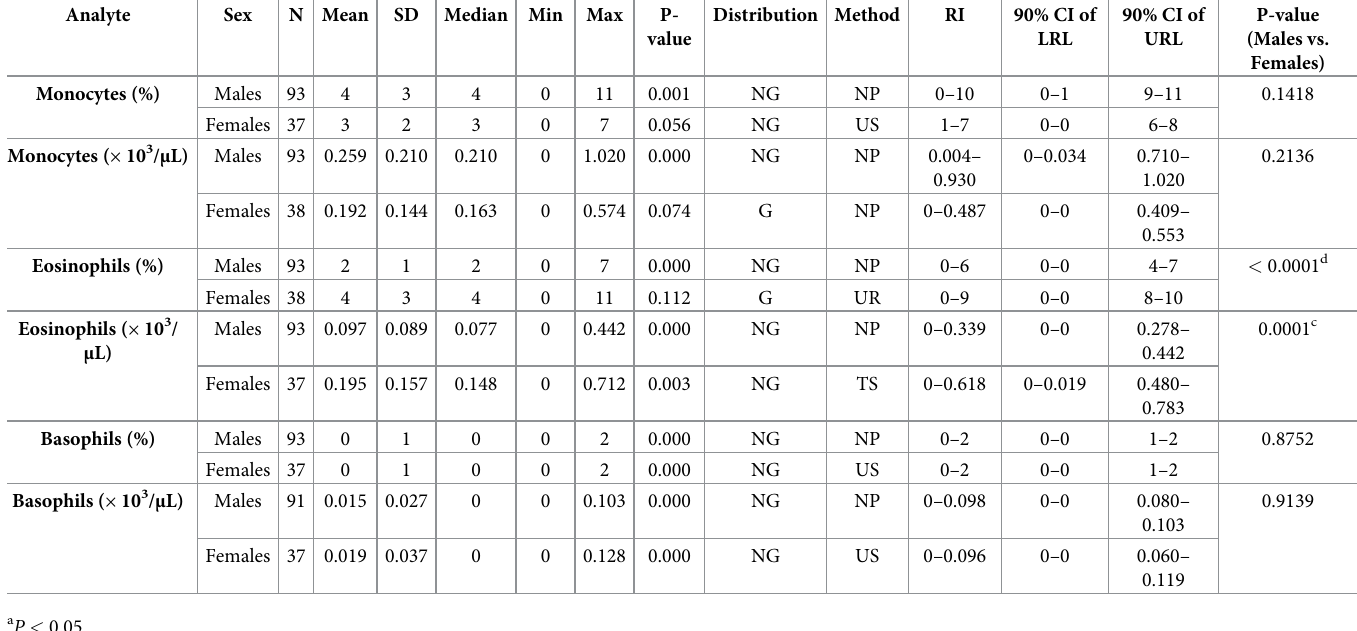
Adult reference intervals for serum biochemistry were partitioned by sex (Table 6). Magne- sium and iron were unavailable from 11 and 23 males, respectively. Due to low blood sample volumes, the following analytes were not tested in all animals: glucose (n = 1 male), BUN (1 male), creatinine (1 male), cholesterol (1 male), anion gap (1 female), and calculated osmolality (1 female). Outliers removed from males included glucose (n = 2), BUN (1), CK (4), total bili- rubin (1), ALT (2), AST (2), potassium (1), and chloride (1). Glucose (n = 2), CK (3), ALT (1), AST (2), and bicarbonate (1) outliers were removed from females. Sex-associated differences in biochemistry parameters are shown in Table 6. Males